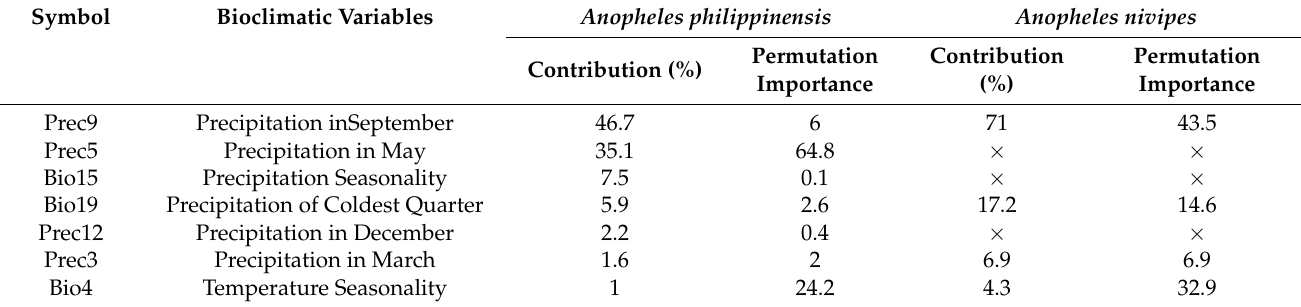
Table 1. Percentage contributions and permutation importance of the bioclimatic variables included in the Maxent models for Anopheles philippinensis and Anopheles nivipes . Variables with contribution less than 1 (indicated by × ) were removed because of high